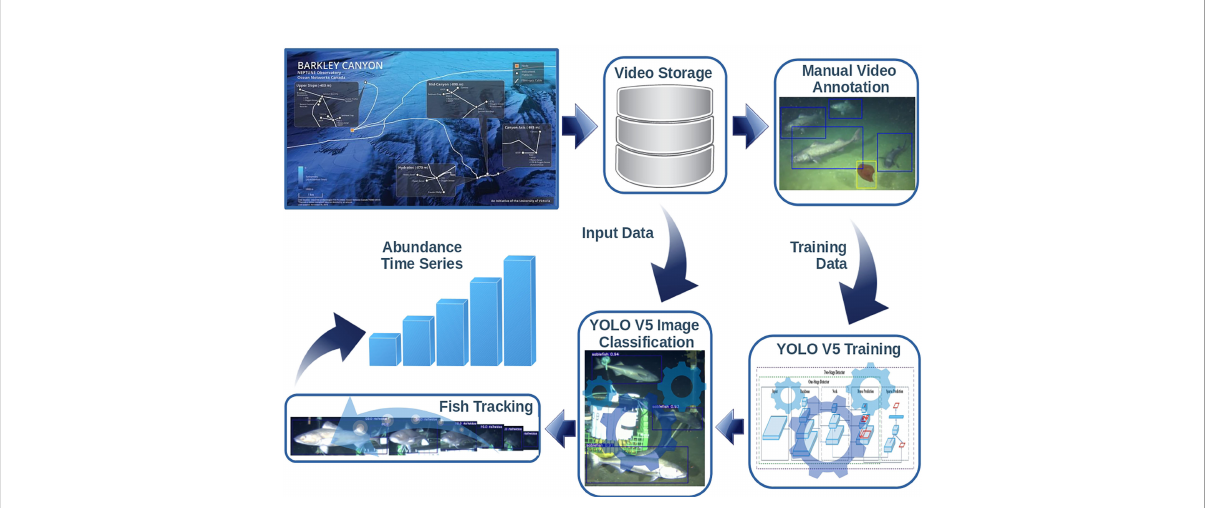
FIGURE 2 Schematic work fl ow of the video imagery data analysis. Frames from the acquired video are selected, manually annotated and used for the training/validation of the sable fi sh classi fi er; Then the trained classi fi er is applied to the footage not used in the training/validation phase producing the bounding boxes of the detected relevant subjects; then the tracking algorithm is used to track the relevant subject moving within the fi eld of view with the aim of producing reliable counts of the framed